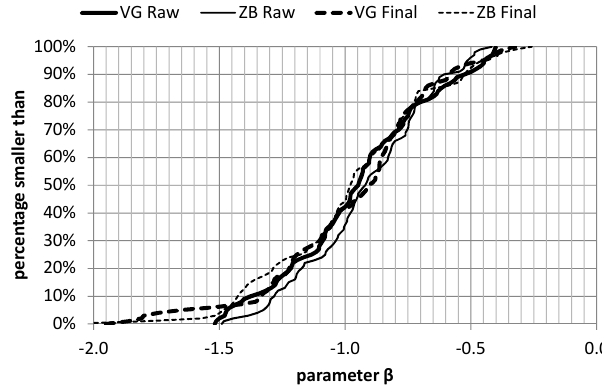
Figure 7. The cumulative distribution of model parameter β